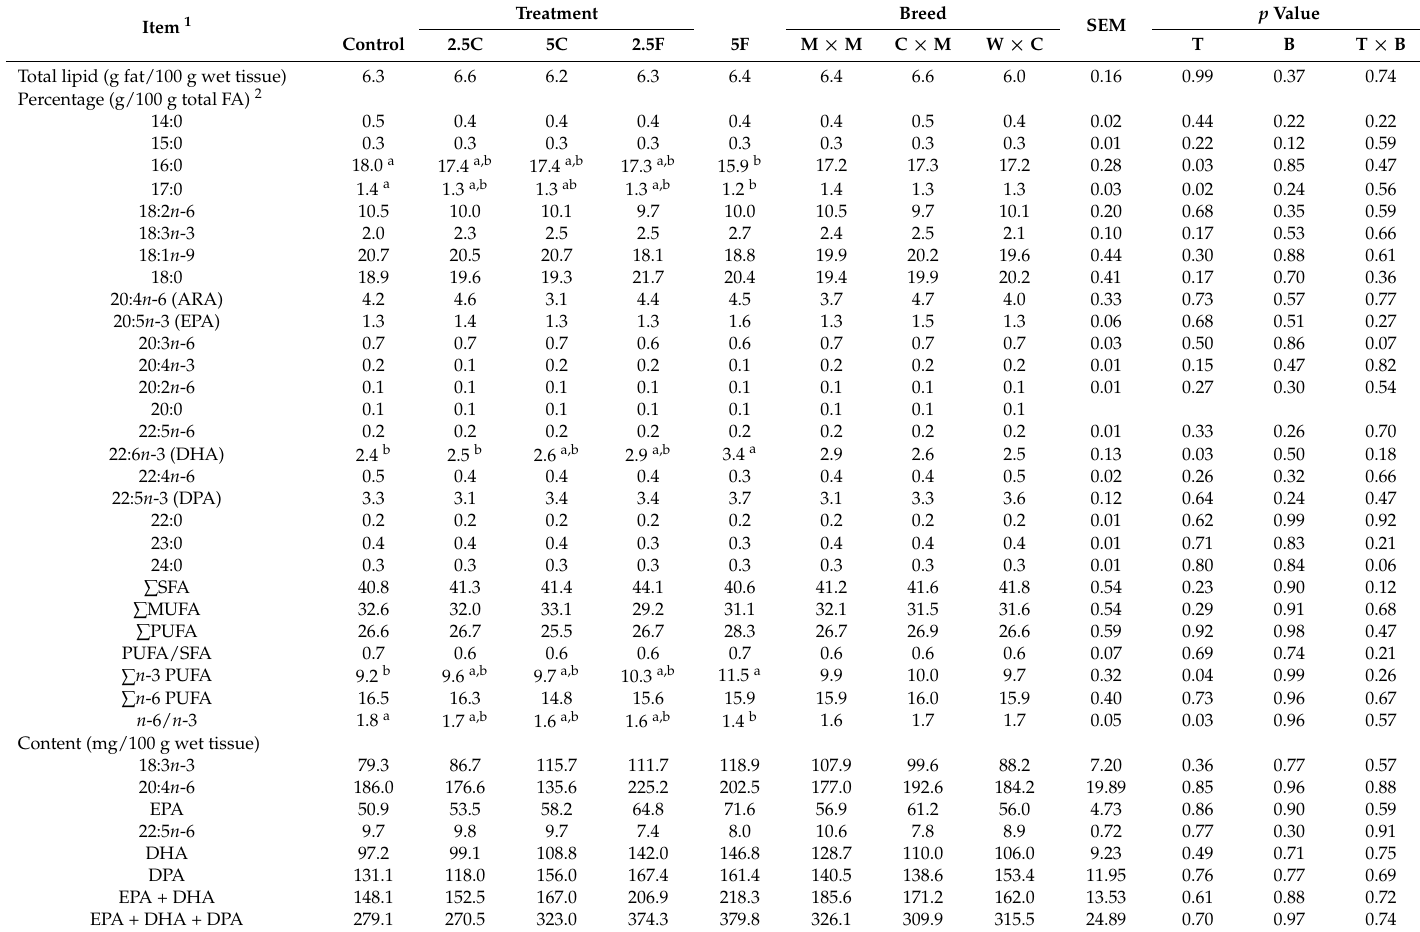
Table 3. Liver fatty acid profile of prime lambs as influenced by omega–3 oil supplementation and